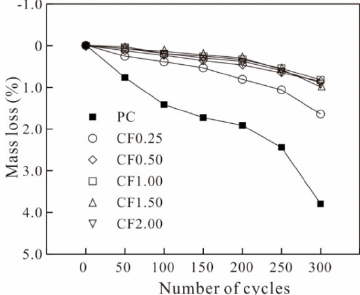
Figure 5. Mass losses of the carbon-fiber-reinforced concrete (CFRC) after different numbers of freeze–thaw cycles. CF, carbon fiber; PC, plain concrete.